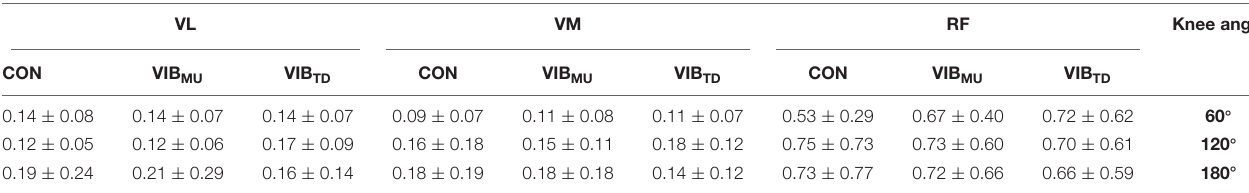
TABLE 1 | Normalized EMG activity (% M max ) before TMS of vastus lateralis (VL), vastus medialis (VM), and rectus femoris (RF) muscles with (VIB MU and VIB TD for muscle and tendon vibration, respectively) and without (CON) vibration. VL VM RF Knee angle